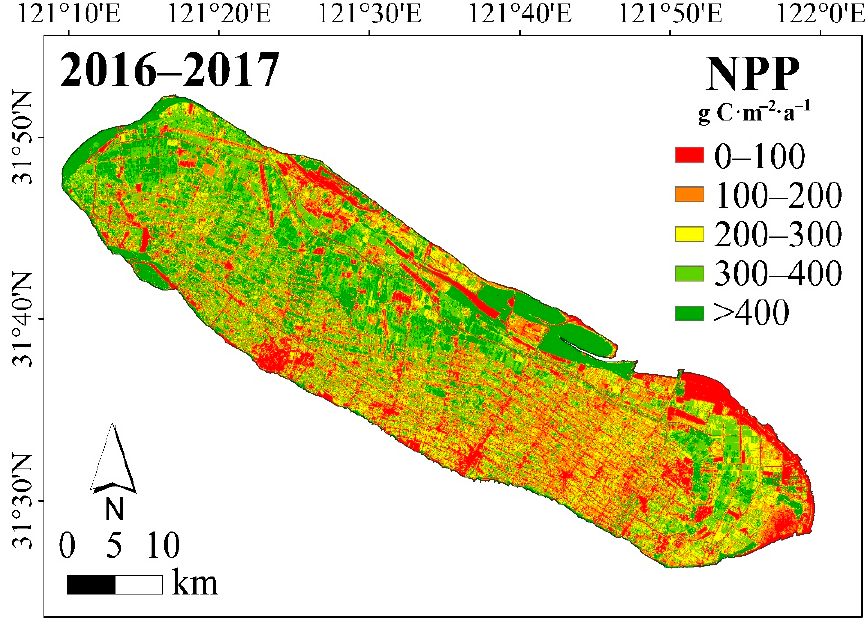
Figure 7. Spatial characteristics of annual vegetation NPP in 2016–2017.